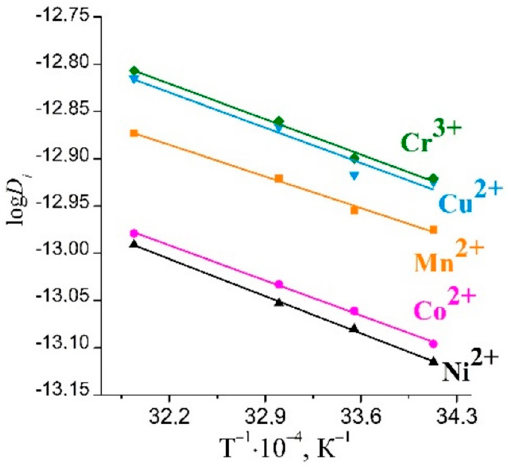
Figure 5. Plot of log D i versus 1/T.